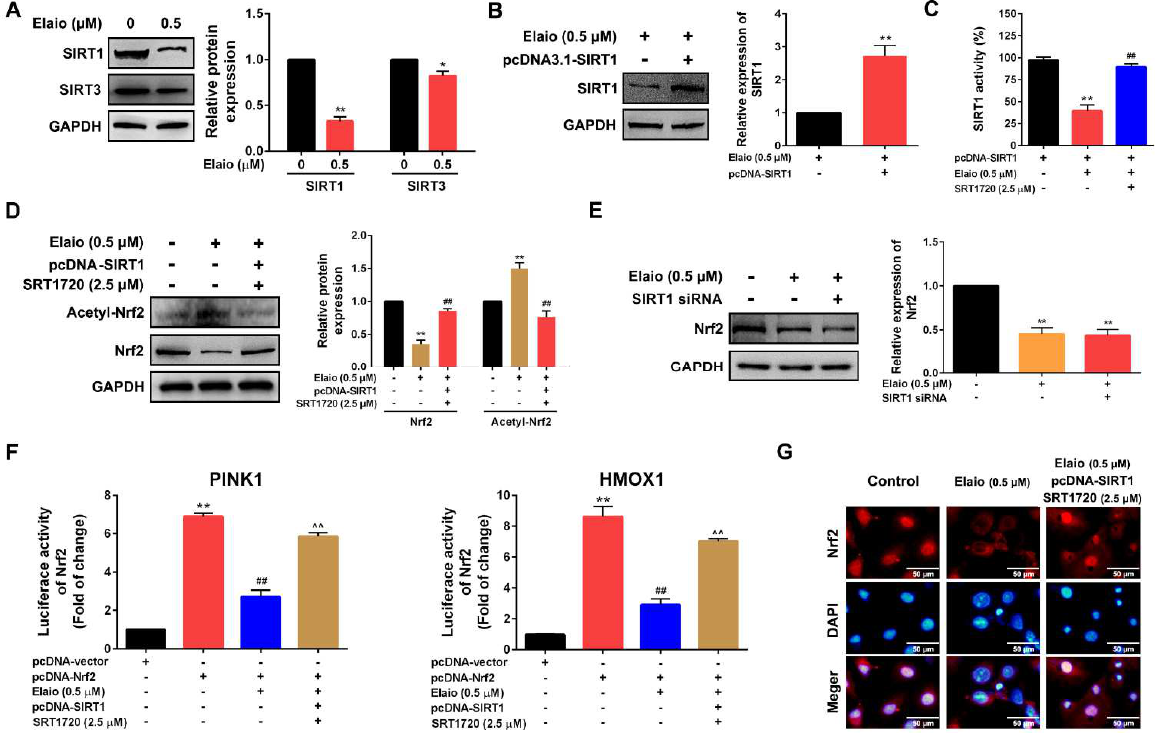
Figure 5. Elaiophylin inhibits mitophagy by regulating SIRT1/Nrf2 signaling in A549 cells. ( A ) A549 cells were exposed to elaiophylin (0.5 µ M) for 24 h and the expression of SIRT1 and SIRT3 were assessed by Western blot analysis. ( B ) SIRT1 was overexpressed in A549 cells. ( C ) A549 cells overexpressing SIRT1 were pre-treated with or without SRT1720 (2.5 µ M) for 24 h and exposed to elaiophylin (0.5 µ M) for 24 h. The activity of SIRT1 was assessed by SIRT1 activity assay. ( D ) A549 cells with SIRT1 overexpression were pre-treated with or without SRT1720 (2.5 µ M) for 24 h and exposed to elaiophylin (0.5 µ M) for 24 h. The expressions of Nrf2 and Acetyl-Nrf2 were assessed by Western blot analysis. ( E ) A549 cells with or without SIRT1 knockdown were exposed to elaiophylin (0.5 µ M) for 24 h. The expression of Nrf2 was assessed by Western blot analysis. * p < 0.05, ** p < 0.01 vs. control, ## p < 0.01 vs. elaiophylin group. ( F ) The transcriptional activity of Nrf2 was assessed by dual-luciferase reporter assay. ** p < 0.01 vs. control, ## p < 0.01 vs. A549 cells with Nrf2 overexpression group. ˆˆ p < 0.01 vs. elaiophylin+pcDNA-Nrf2 group. ( G ) Localization of Nrf2 was assessed by immunofluorescence staining. Data were expressed as means ± SD of three experiments and each experiment included triplicated repeats. Original Western Blots can be found at supplementary